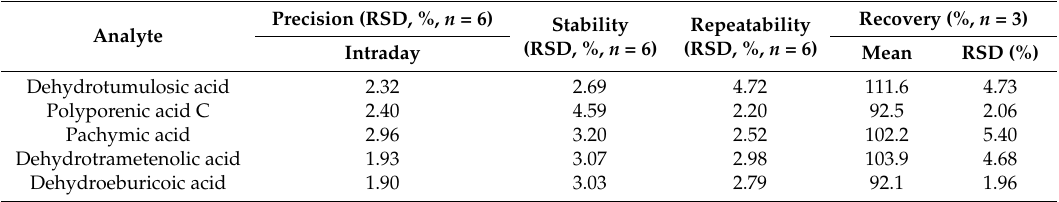
Table 2. Precision, repeatability, stability, and recovery of the five investigated analytes.